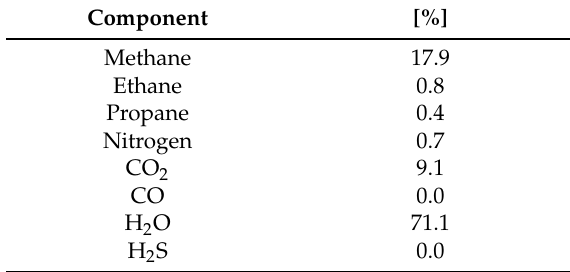
Table 5. Estimated composition of feed stream for the MR. Table 6. Estimated conditions of the feed stream for the MR.